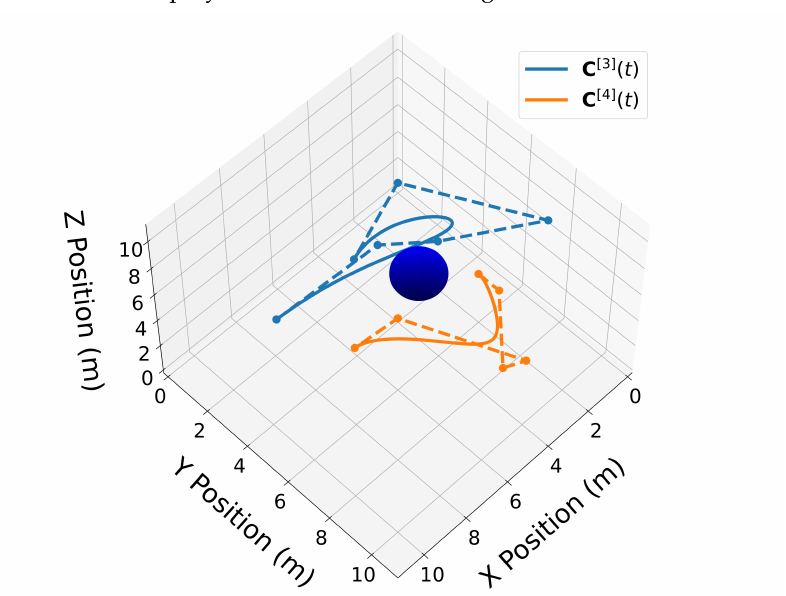
Figure 10. Two 3D Bernstein polynomial trajectories near a spherical obstacle. Trajectory C [ 3 ] ( t ) is drawn in blue and trajectory C [ 4 ] ( t ) is drawn in